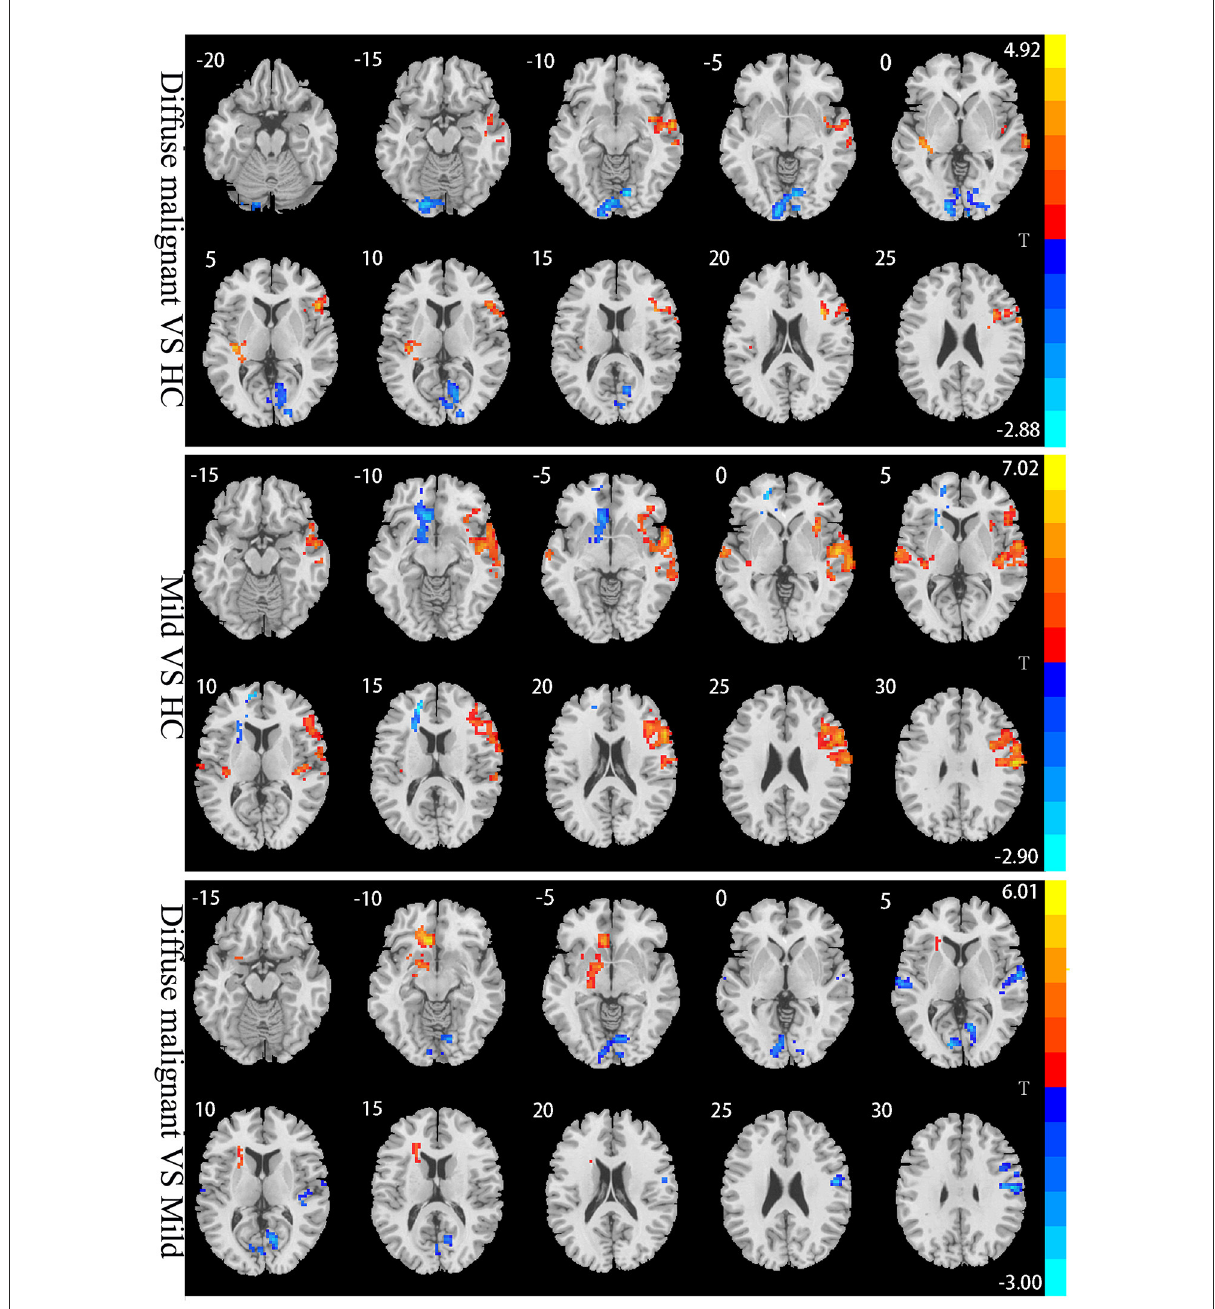
FIGURE2 Statistical parametric map showing the significant differences in the ALFF between three groups: Diffuse malignant subtype, Mild and HC. GRF corrected (Voxel p < 0.005, cluster p < 0.05). The color bar on the right indicates the statistical t-value. Warm (cold) overlays indicate higher (lower) ALFF in PD